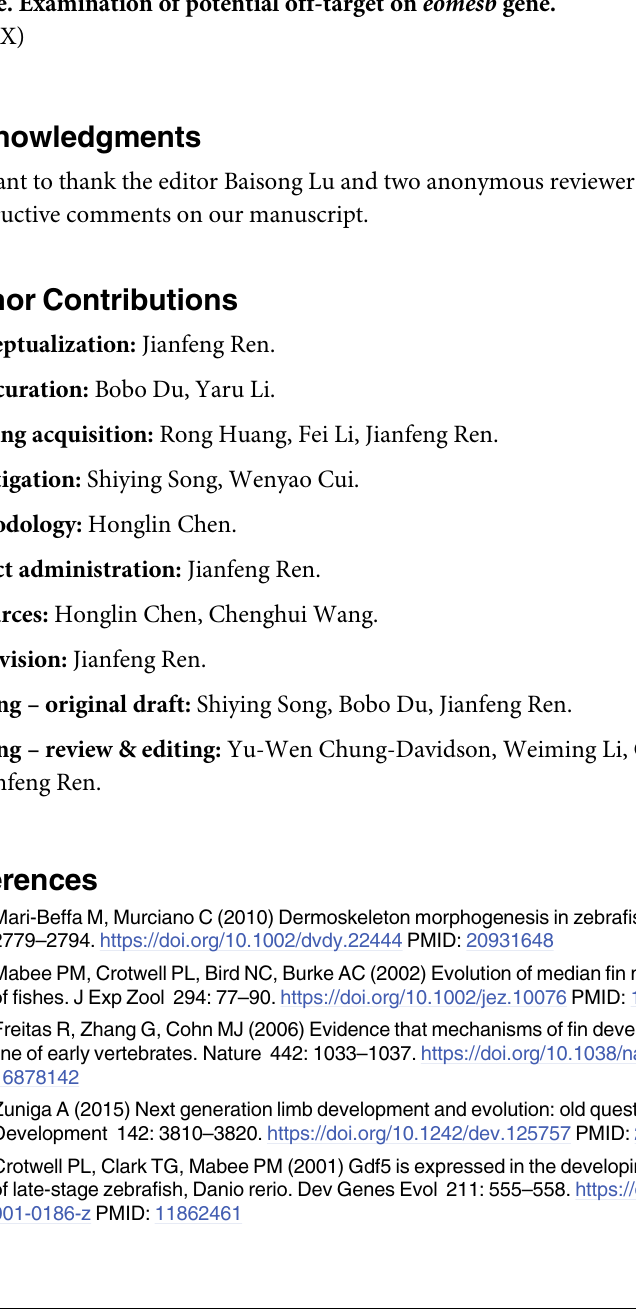
S5 Table. The statistics of the mutation types on 24 hpf embryos. S6 Table. The individual knockout efficiency on 7 dpf larvae with three random individu- als. S7 Table. The statistics of the mutation types on 7 dpf larvae. S8 Table. Mutation types in three mosaic